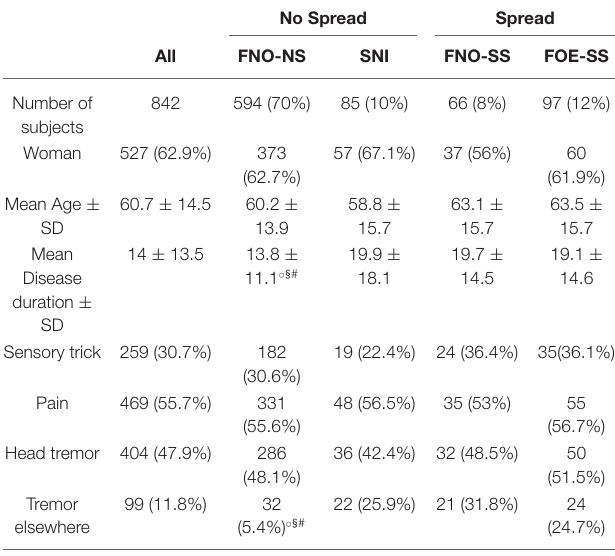
TABLE 1 | Demographic data.